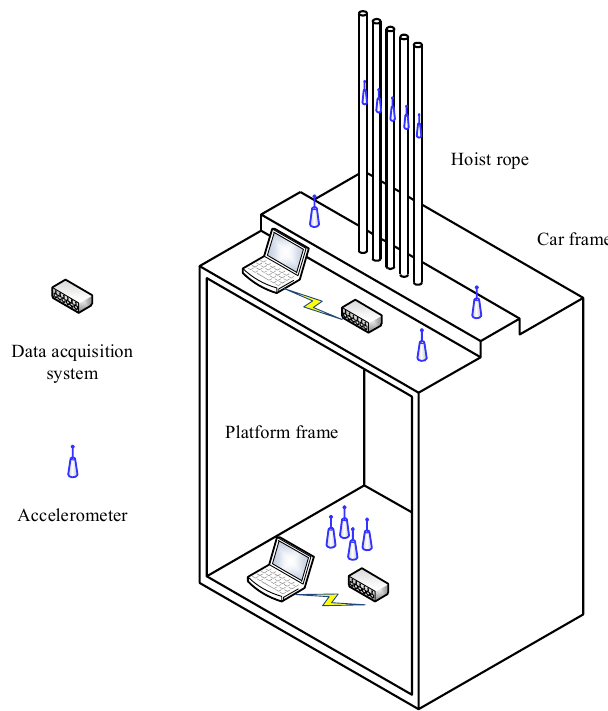
Figure 4. Arrangement of sensors on the platform frame.